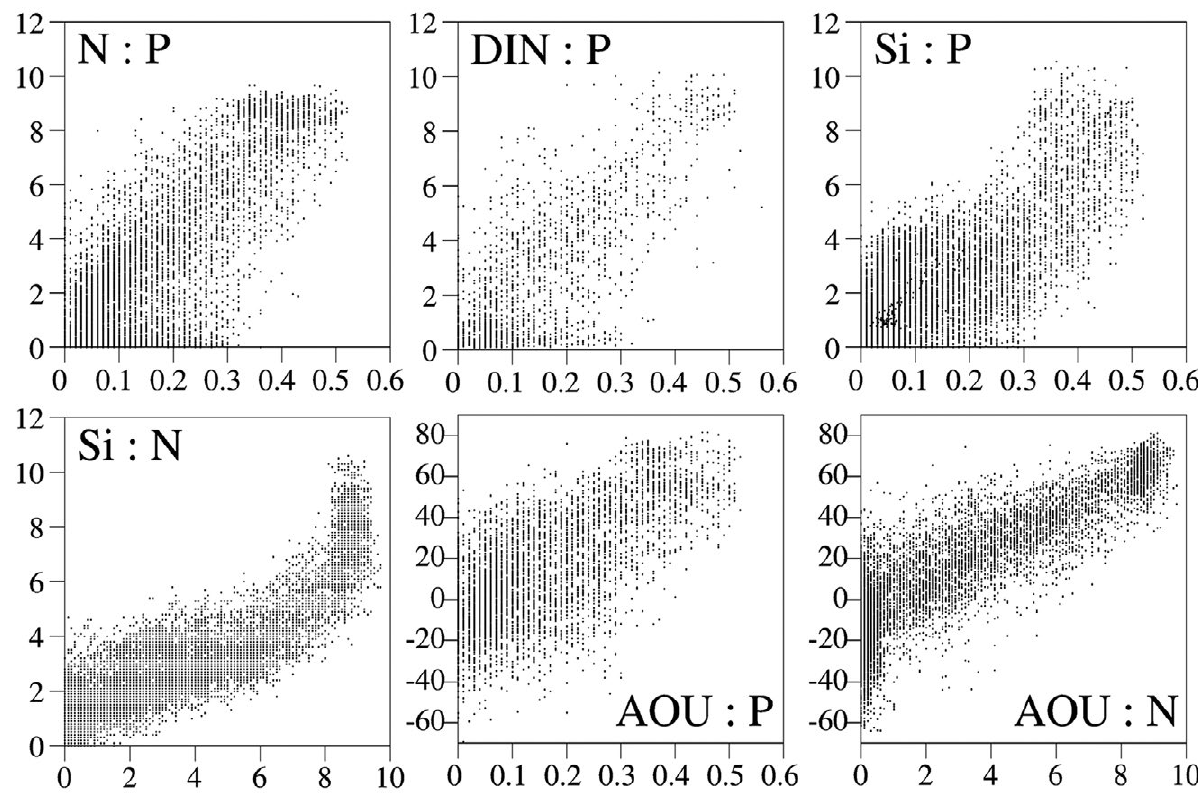
Fig. 7. – Scatter plots of nitrate vs. phosphate (N:P), dissolved inorganic nitrogen vs. phosphate (DIN:P), silicate vs. phosphate (Si:P), silicate vs. nitrate (Si:N), apparent oxygen utilization vs. phosphate (AOU:P) and AOU vs. nitrate